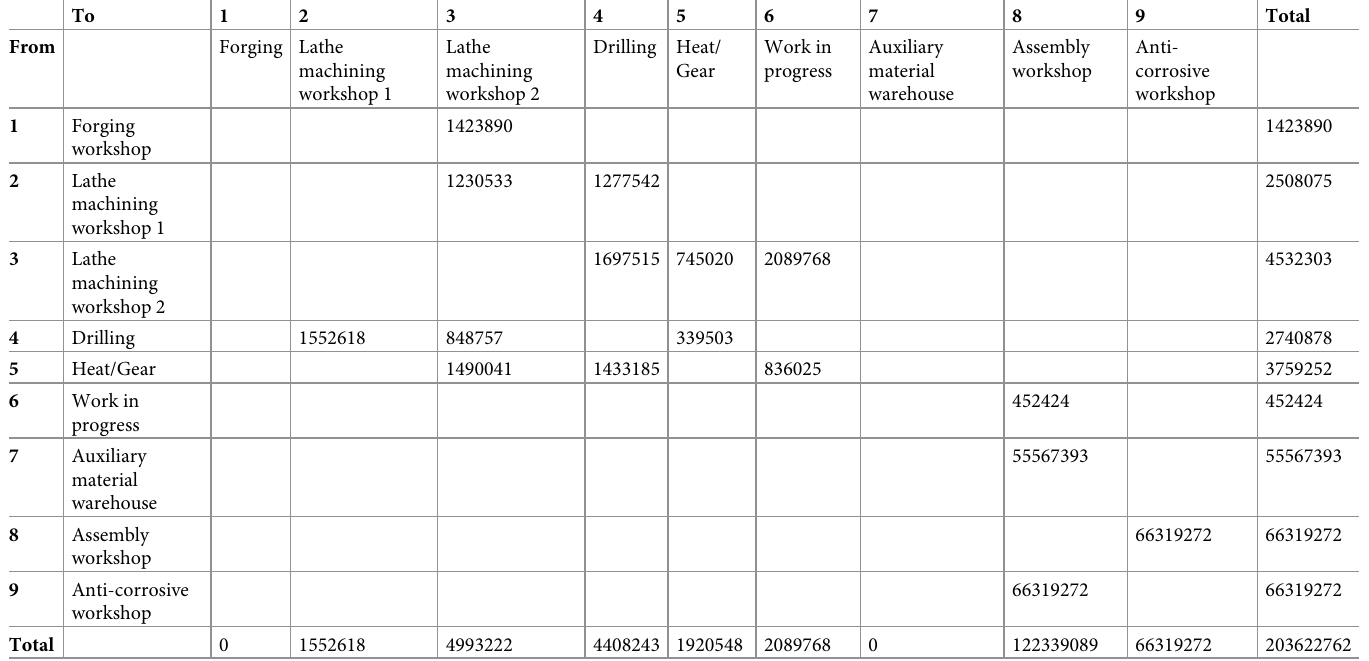
Table 4. Summary of the logistics intensity of the production unit of the bearing plan. To